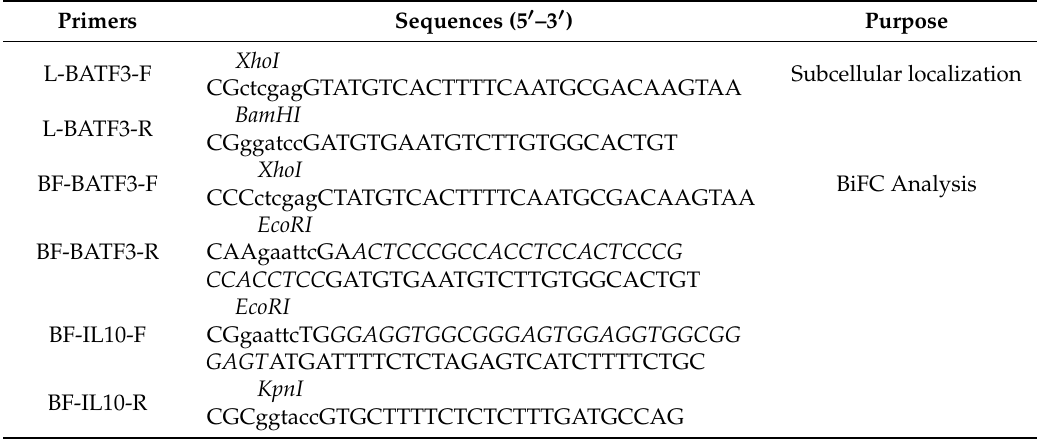
Table 3. Primers used in plasmid construction. The different restriction sites are shown in lowercase letters and the names are represented above the respective